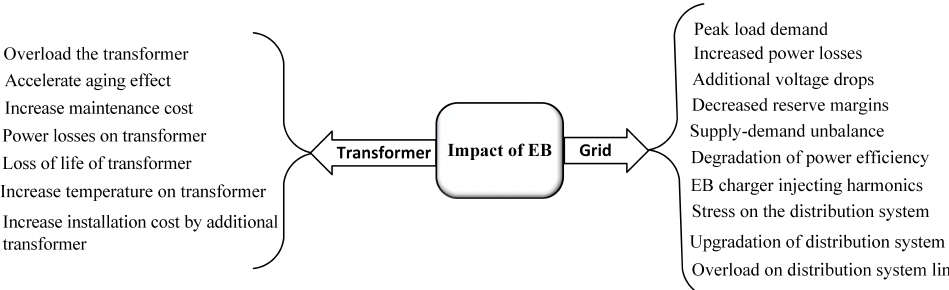
Figure 6. Impact on the transformer and